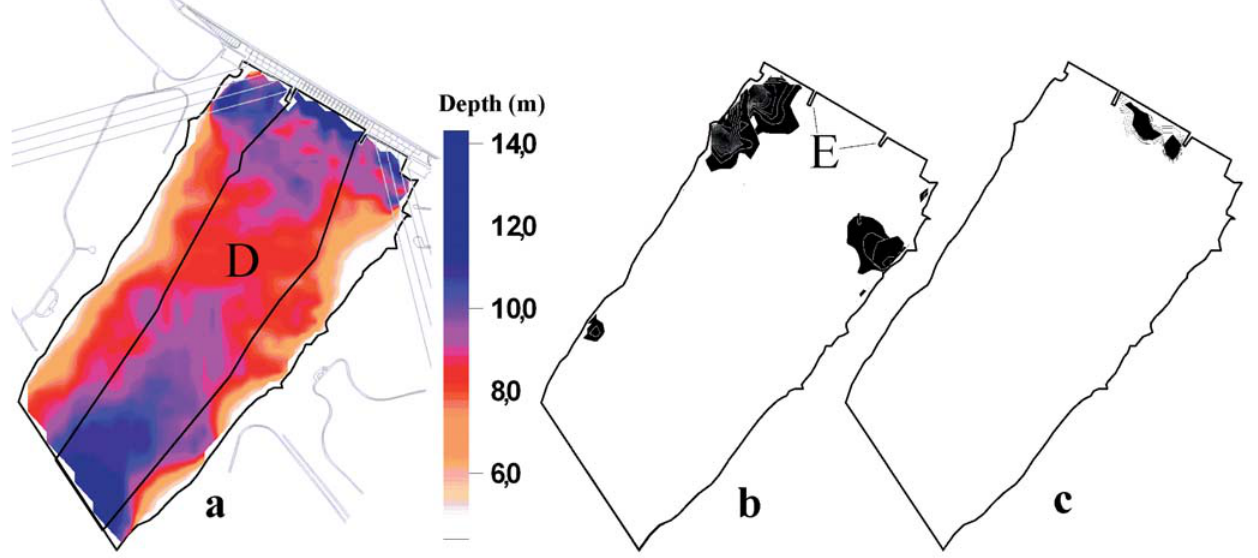
Fig. 10. Fish distribution and density in the tailwater of Salto Grande Dam. a) Depth distribution. b) Areas of maximum fish concentration (16 fish/m 2 ), November, 2002, with opened spillway. c) Areas of maximum fish concentration (29 fish/m 2 ) Novem- ber, 2000, with closed spillway. D - bubble area produced by spillway. E - fishway